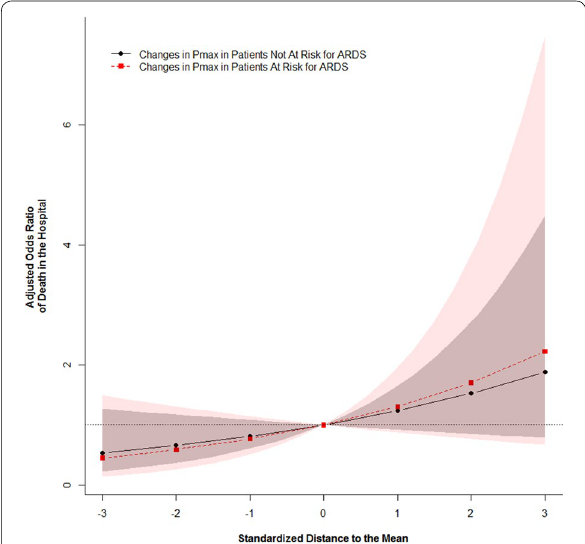
Fig. 3 Odds ratio of hospital mortality according to increases in one standard deviation of P max and in the patients at risk and not at risk of ARDS. All curves are adjusted by the same set of variables